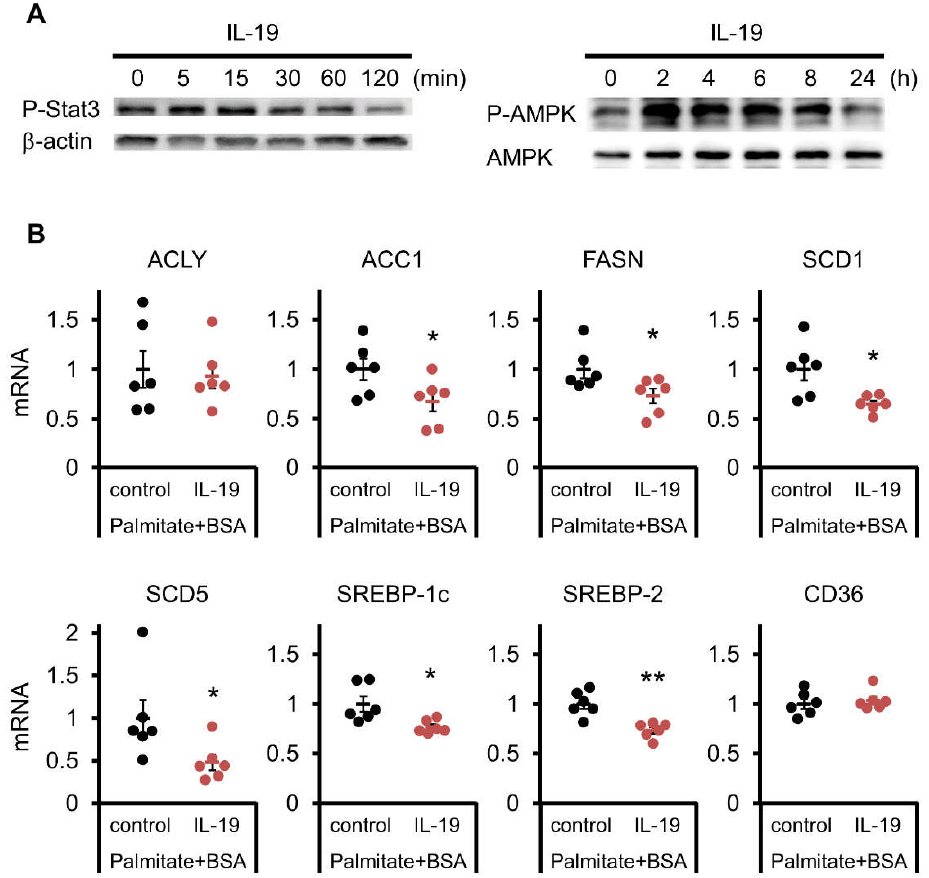
Figure 6. Signaling factors that respond to IL-19. ( A ) HepG2 cells were treated with 100 ng/mL IL-19. Total cell lysates were prepared and blotted with antibodies against the phosphorylated form of STAT3 and phosphorylated and non-phosphorylated forms of AMPK. Representative images are shown ( n = 4). ( B ) HepG2 cells were treated with 200 μM palmitate-BSA and 100 ng/mL IL-19 for 48 h. The mRNA expression levels of each factor were evaluated by QPCR ( n = 6). * p < 0.05, ** p < 0.01 vs. control.